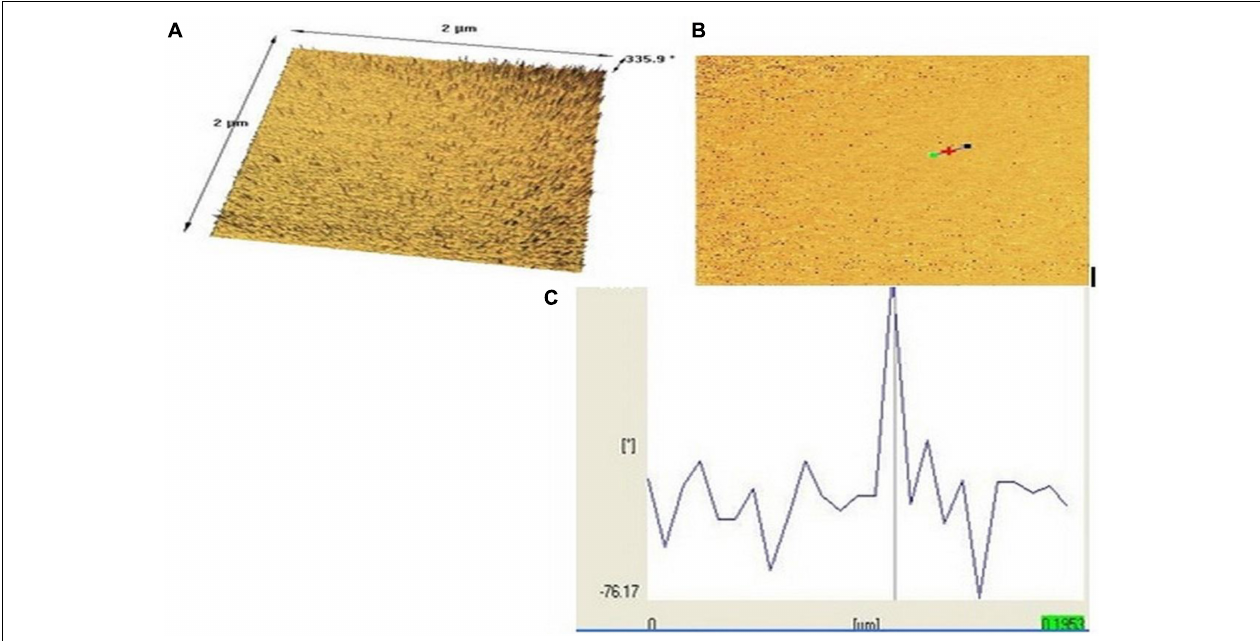
FIGURE 6 | Nanopolymer AFM images of surface morphology [top (A) , bottom (B) , and (C) topographical view]. (*) has been done by the operator of the atomic force microscopy (AFM) to indicate the particle distance and